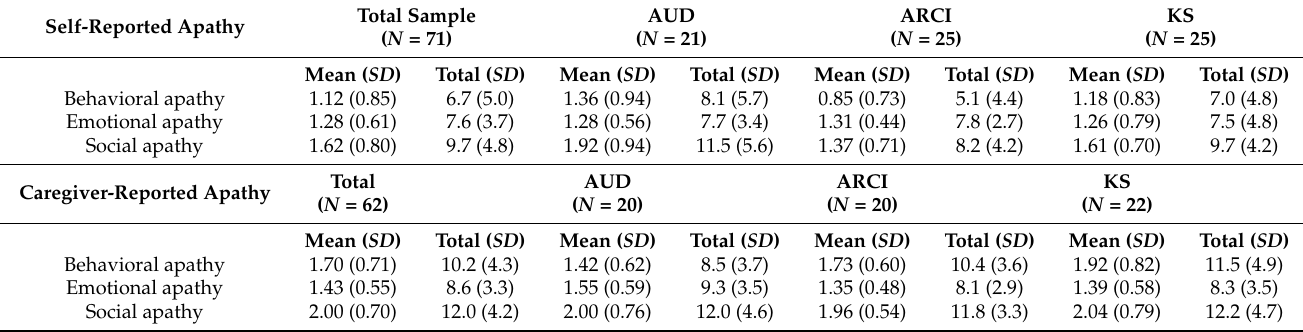
Table A1. Mean ratings and standard deviations of average and total scores of self-reported and caregiver-reported behavioral, emotional and social apathy assessed using the apathy motivation index (AMI) for the total study-population and the patient groups separately: patients with alcohol use disorder (AUD), alcohol-related cognitive impairments (ARCI) and Korsakoff’s syndrome